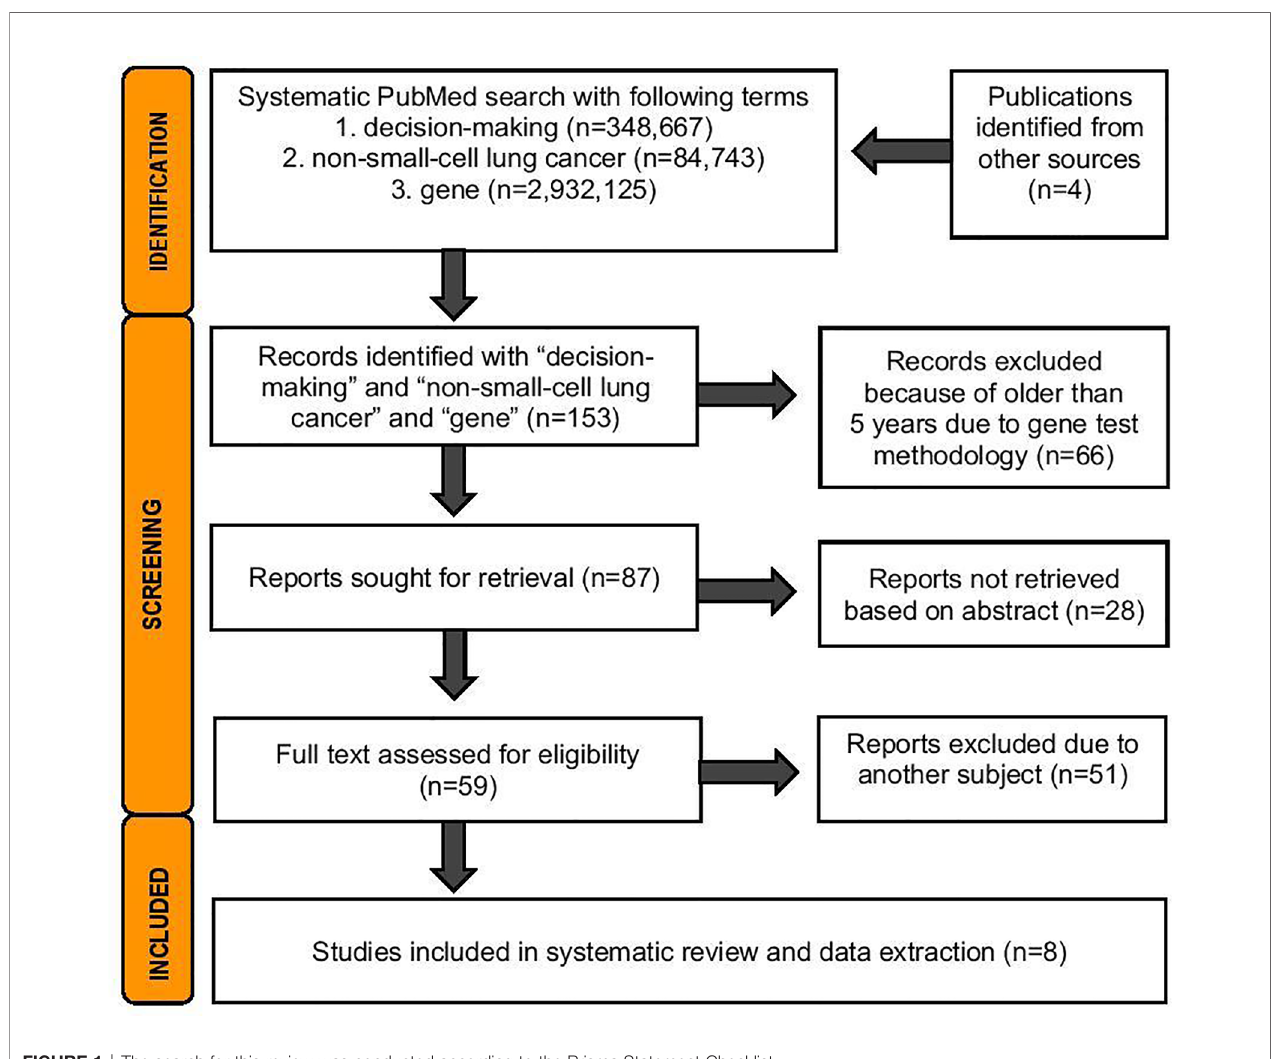
FIGURE 1 | The search for this review was conducted according to the Prisma Statement